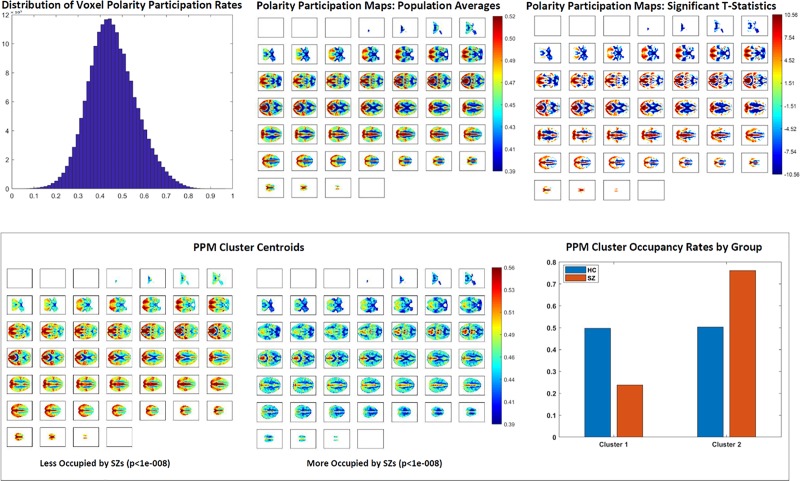
(Top Left) Population-wide voxel polarity participation rates are normally distributed with mean μ = 0.46 and standard deviation σ = 0.11; (Top Middle) Population average voxelwise polarity participation rates displayed on axial slices from z = 1 on upper left through z = 46 lower right corner; (Top Right) Significant (p<0.05 (FDR)) voxelwise t-statistics for difference from the mean polarity participation rate; (Bottom Left and Middle) Subject-level polarity participation maps fall robustly into two clusters. Cluster 1 presents regions with above average participation rates, average participation rates and, predominantly ventricular areas with below average participation. The regions with above average participation are much smaller in Cluster 2 than Cluster 1 and the areas with average and below average participation much larger in Cluster 2; (Bottom Right) Healthy subjects split evenly between the two clusters while schizophrenia patients occupy Cluster 2 much more often than Cluster 1.